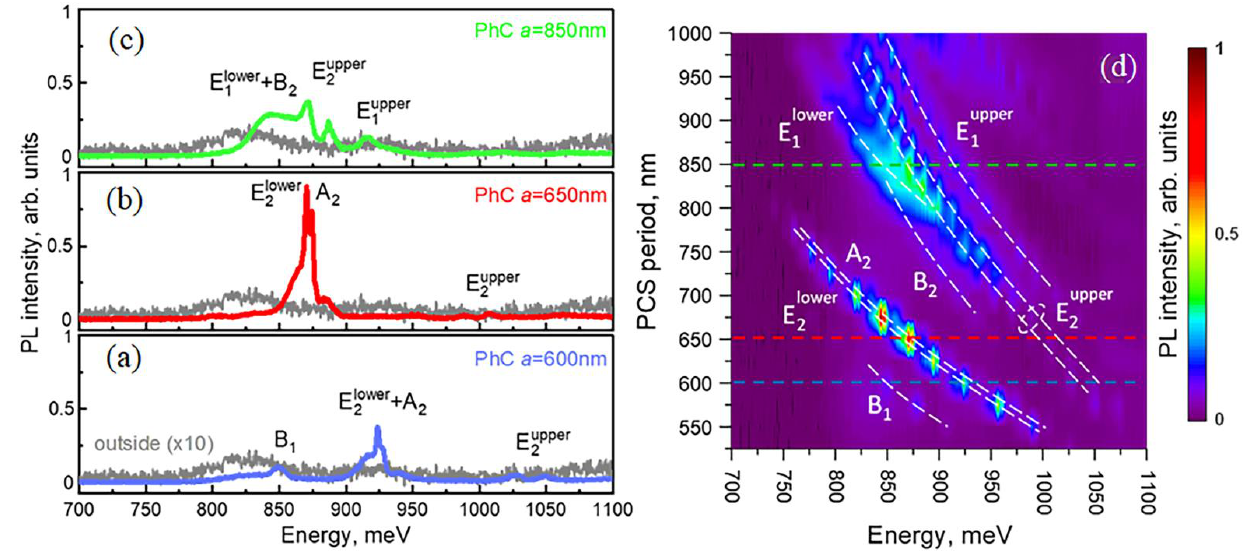
Figure 3. ( a – c ) — spectra measured using micro-PL setup in the area outside of the PCSs and within the PCSs with periods a = 600 nm ( a ), 650 nm ( b ) and 850 nm ( c ) The spectrum measured in the area outside the PCSs is multiplied by 10. ( d ) — 2D representation of micro-PL spectra as a function of energy and PCS period. The dashed lines of the corresponding color denote the spectra of PCSs presented in figures ( a – c ). The letters denote the PCS’s modes associated with the corresponding peaks in the micro-PL spectra (modes designation taken from [38]).